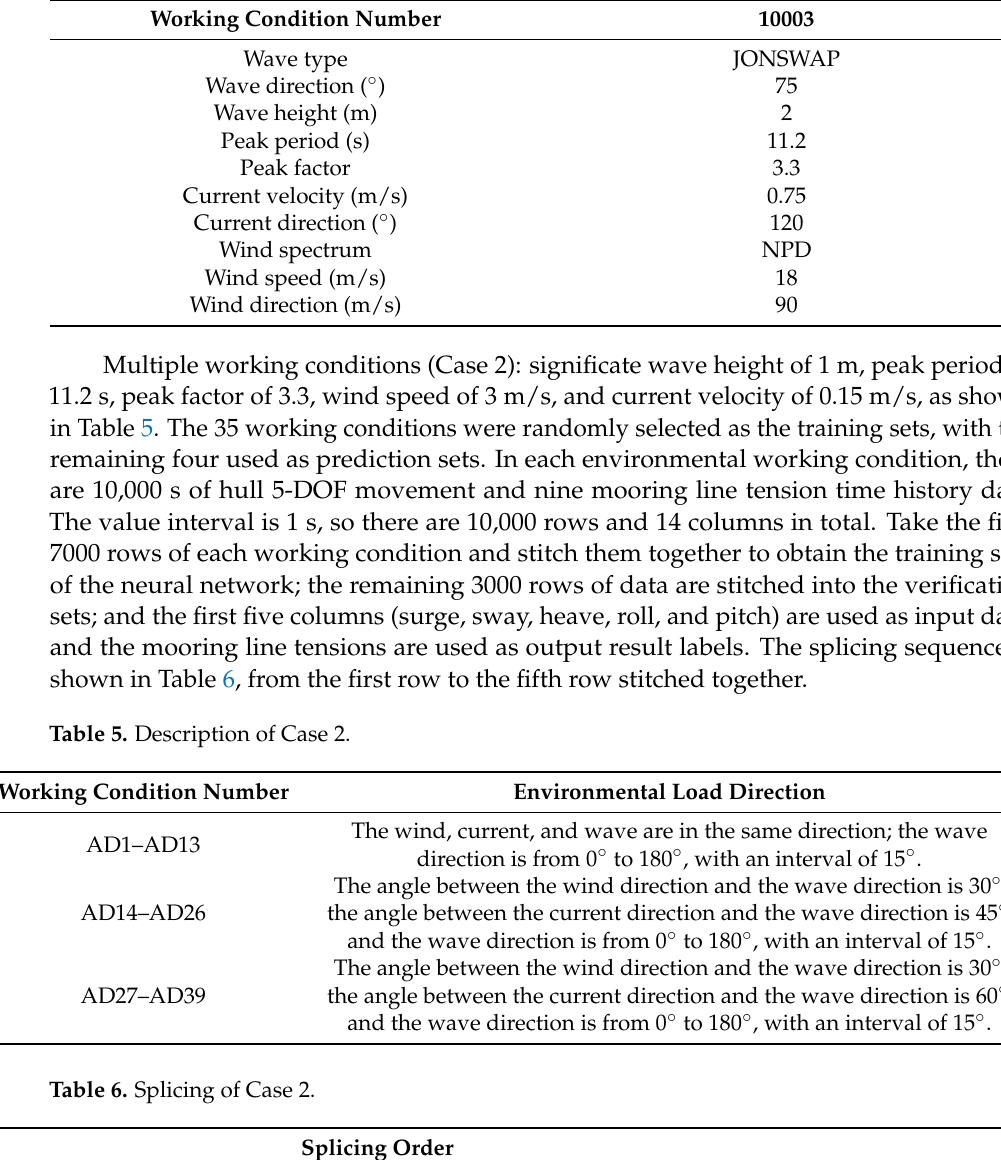
Table 4. Description of Case 1.